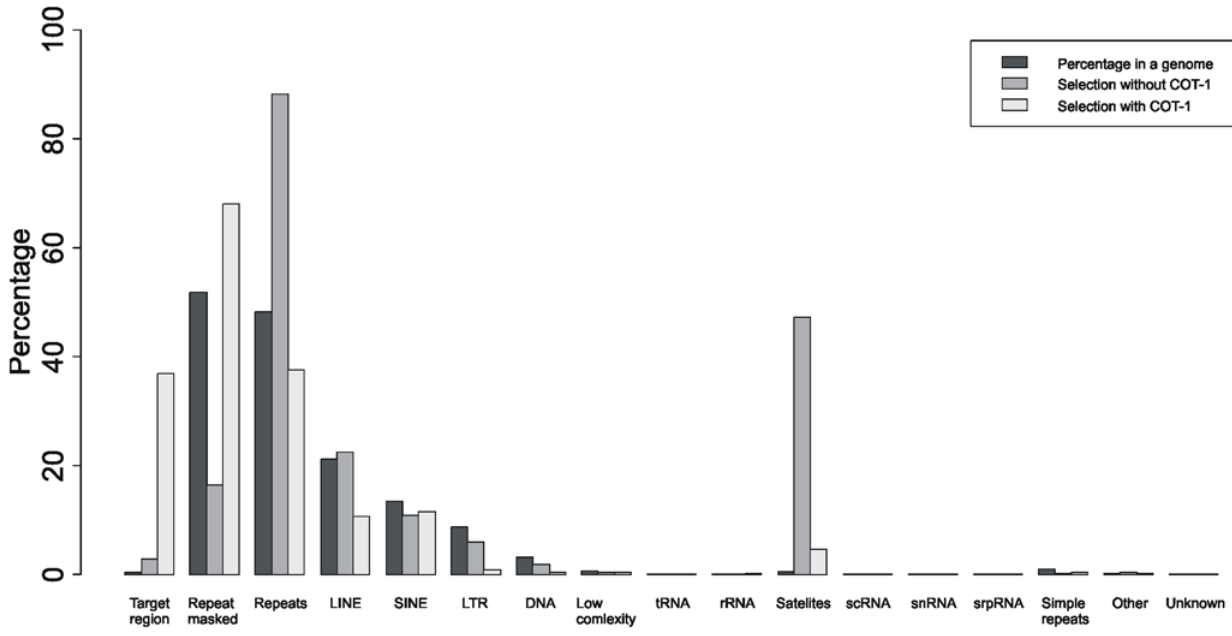
Figure 2. Proportion of different genomic elements in the captured samples with and without COT-I DNA as compared to their relative abundance in the human genome. Reads were mapped to the reference human genome using BLAT, allowing 2 mismatches and 1 indel with a minimal perfect match of 30 bp. doi:10.1371/journal.pone.0006659.g002 (G-C) base pair, AT rich probes are longer (median mean annealing temperature of probes in the low coverage regions length = 56 bp) than in regions which yield good sequence (median= 71.6 u C) compared to the regions with the good coverage (median =45 bp, Fig. 4a). This also results in a lower coverage (median= 77.5 u C, Fig. 4g).